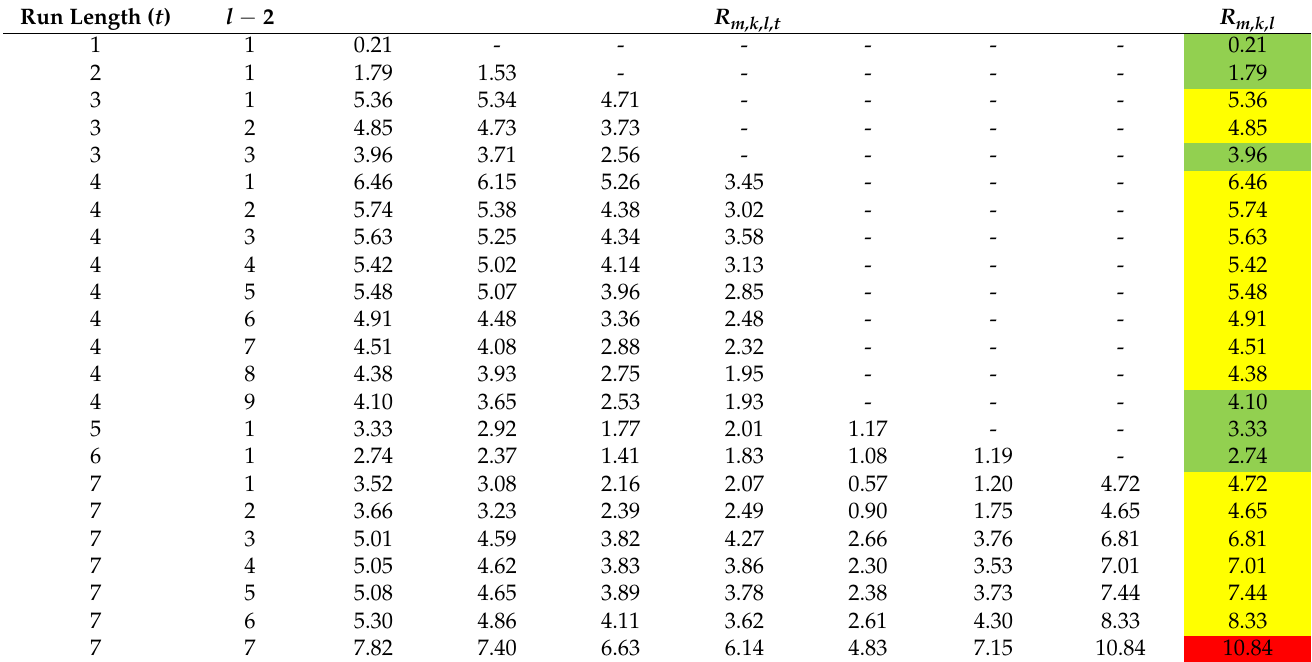
Table 7. The values of GLR statistics in each run of simulation (yellow, green, and red cells are indicators of a requirement for a new sample, in-control, and out-control situations,